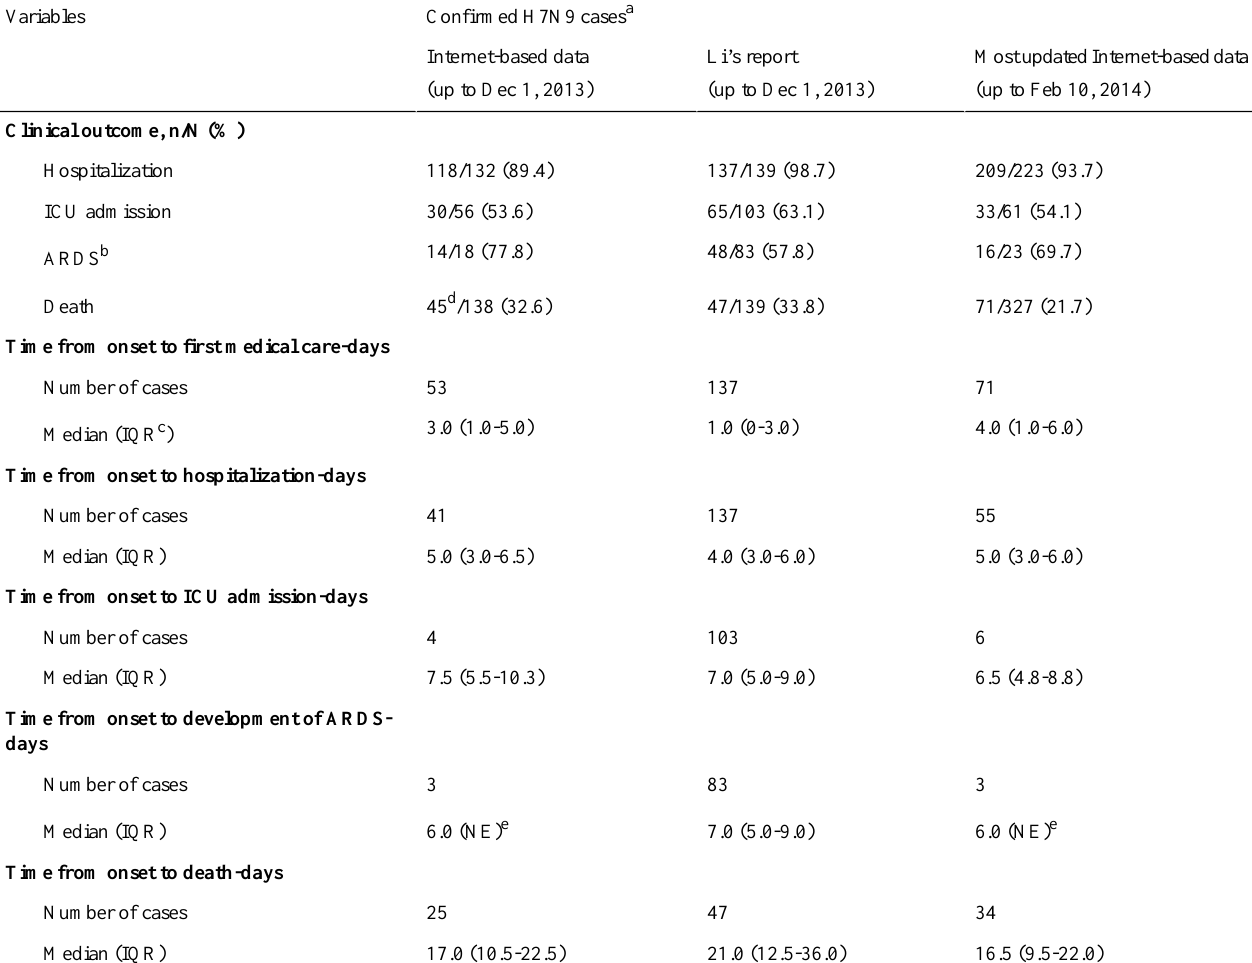
Table 2. Clinical characteristics and medical care timelines for patients with confirmed H7N9 infection in China from early 2013 to February 10,